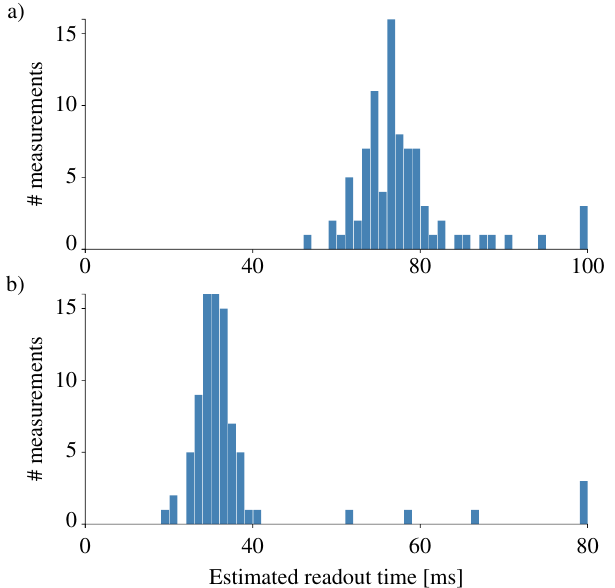
Figure 5: Estimated readout time for each image of the Phantom 2 Vision+ at 8m / s (a) and Inspire 1 at 8m / s (b) datasets. The median value for the Phantom 2 is 74ms (DJI confirmed 73ms ).